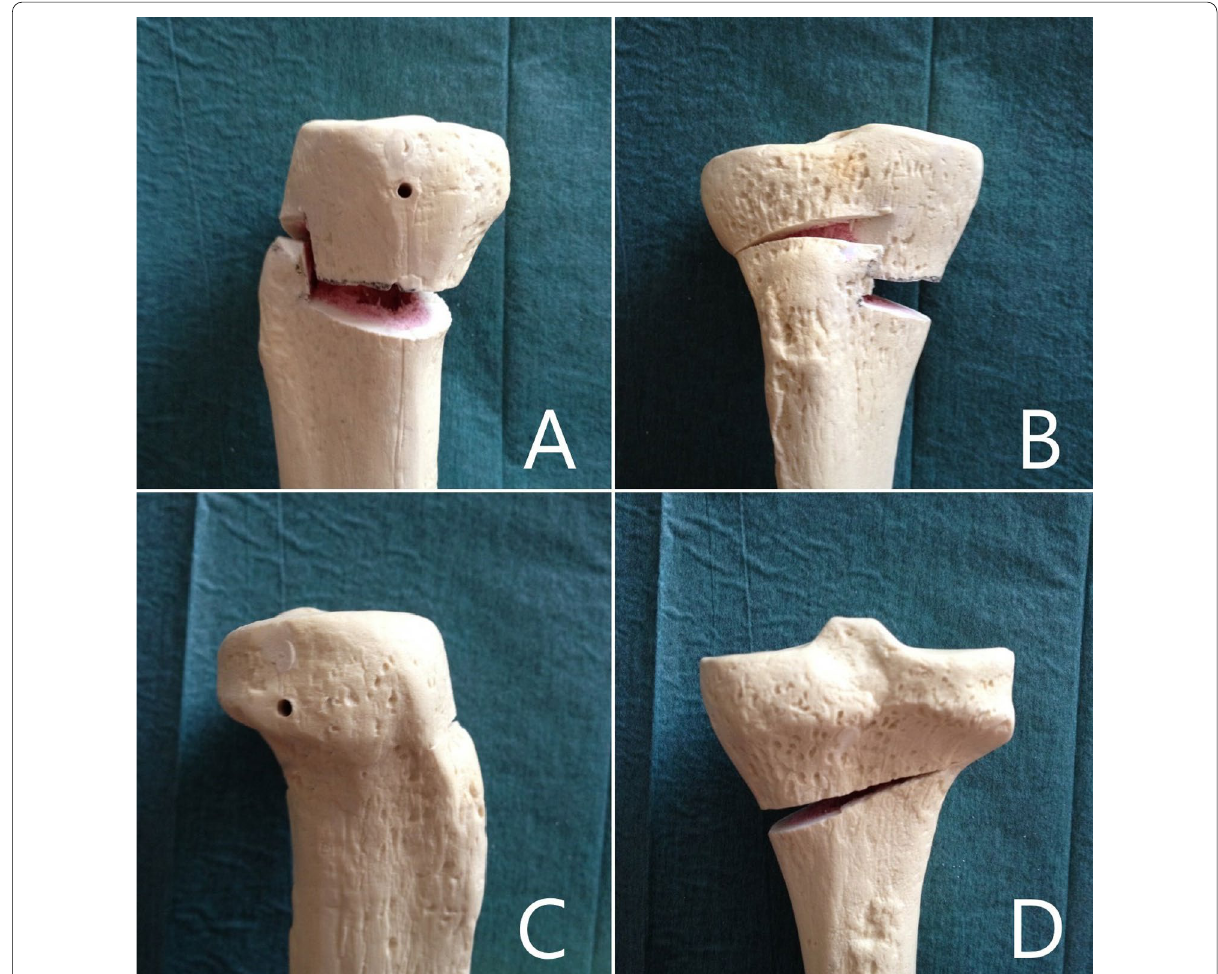
Fig. 1 Reproduction of Z-shaped biplanar medial opening-wedge high tibia osteotomy technique on artificial bone model of left proximal tibial: A medial, B anterior, C lateral, and D posterior